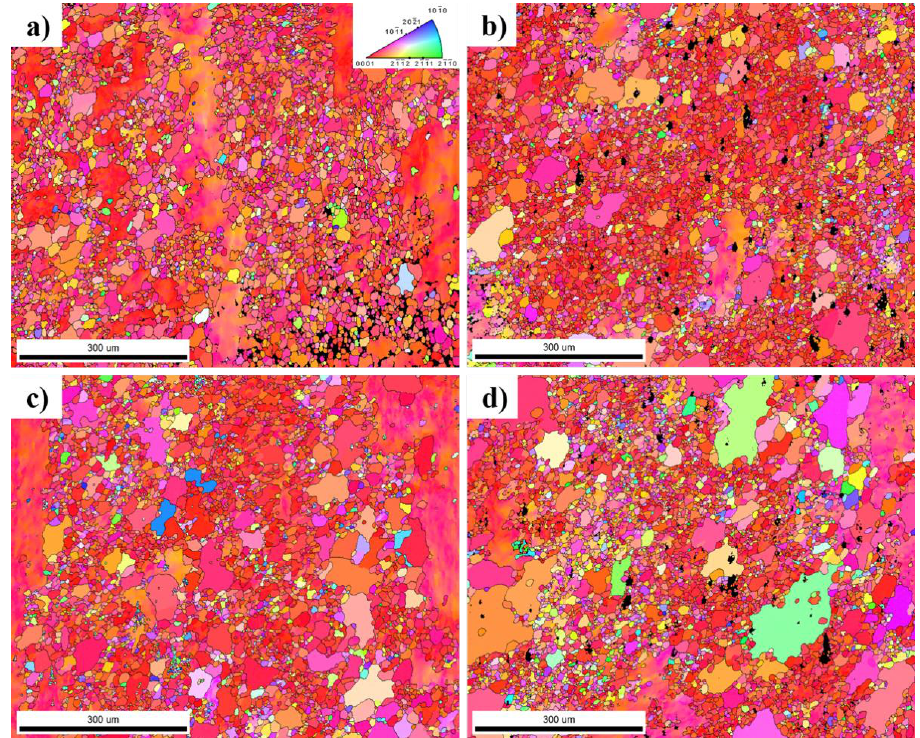
Figure 4. Inverse pole figure (IPF) maps ( ∥ Extrusion direction (ED)) outlining different micro- structures in the weld-free region before and after heat treatments at 475 °C (flat section): ( a ) as-extruded, ( b ) after 400 s, ( c ) after 1200 s, and ( d ) 3600 s, ED parallel to the weld line, ER = 8:1.